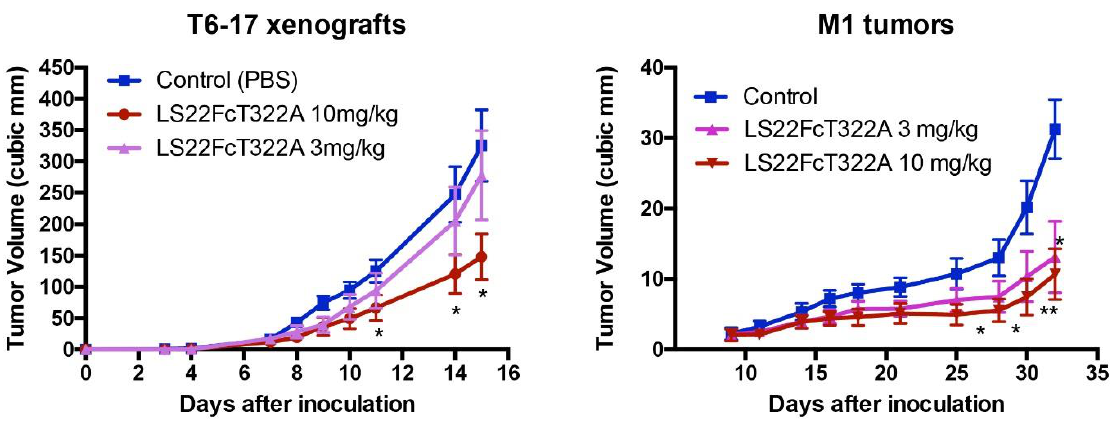
Figure 5. Inhibition of tumor growth. In the animal model of athymic mice carrying T6-17 or M1 xenografts, LS22FcT322A demonstrated dose-dependent activity. T6-17 and M1 tumors were established by subcutaneously implanting 5 × 10 4 and 1 × 10 6 cells, respectively, into the flank of nude mice. For T6-17 tumors, treatment started the next day after tumor inoculation. For M1 tumors, treatment started 10 days after. Mice were treated three times per week at two different dosages (3 mg/kg or 10mg/kg, i.p.). t test was performed to compare the difference between the size of tumors in the treated group and the control group. *: p < 0.05; **: p < 0.01.